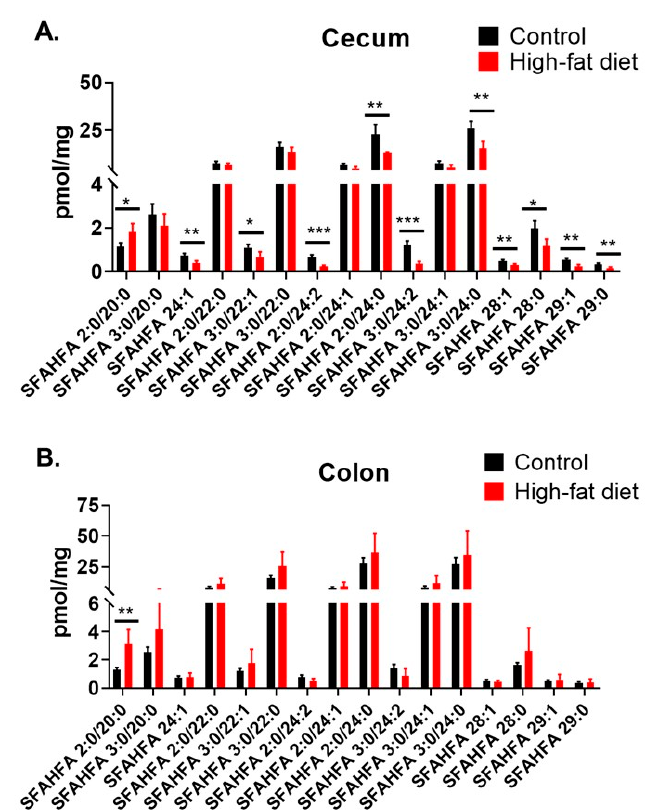
Figure 6. Amount of DMED-labeled SFAHFAs in contents of the cecum ( A ) and colon ( B ), of rats fed a normal diet (as controls) and HFD. (n = 6 each for cecum contents, n = 6 for control of colon contents and n = 3 for HFD group, *** p < 0.005, ** p < 0.05, * p < 0.1).